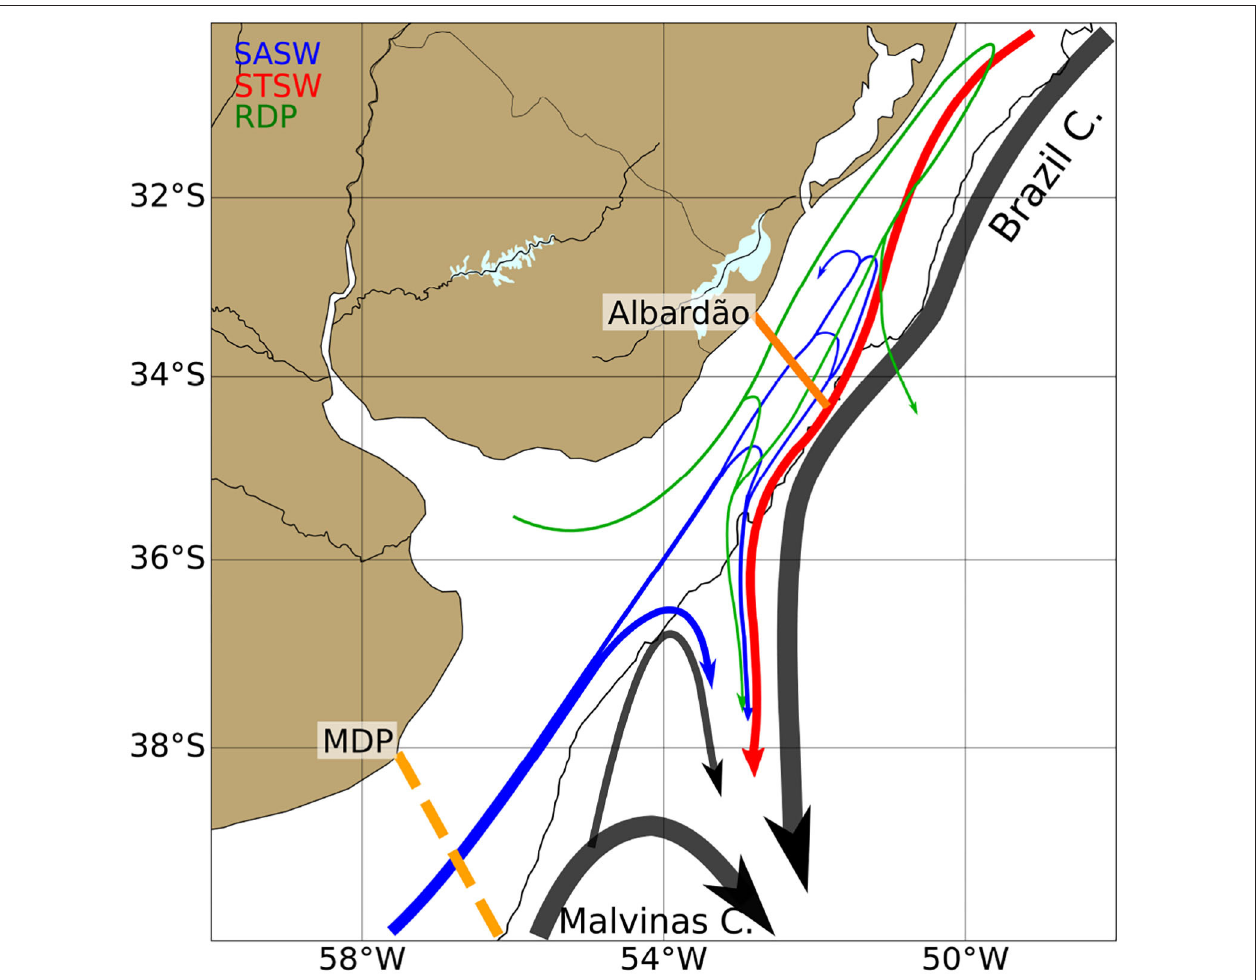
FIGURE 1 | Schematic circulation diagram of the Southwestern Atlantic Shelf between 30 and 40 ◦ S. The Mar del Plata (MDP) and Albardão transects are indicated by an orange dashed and solid line, respectively. The gray line indicates the 200 m isobath. SASW, Subantarctic Shelf Water (blue); STSW, Subtropical Shelf Water (red); RDP, Río de la Plata water (green). Adapted from Berden et al. (2020) with